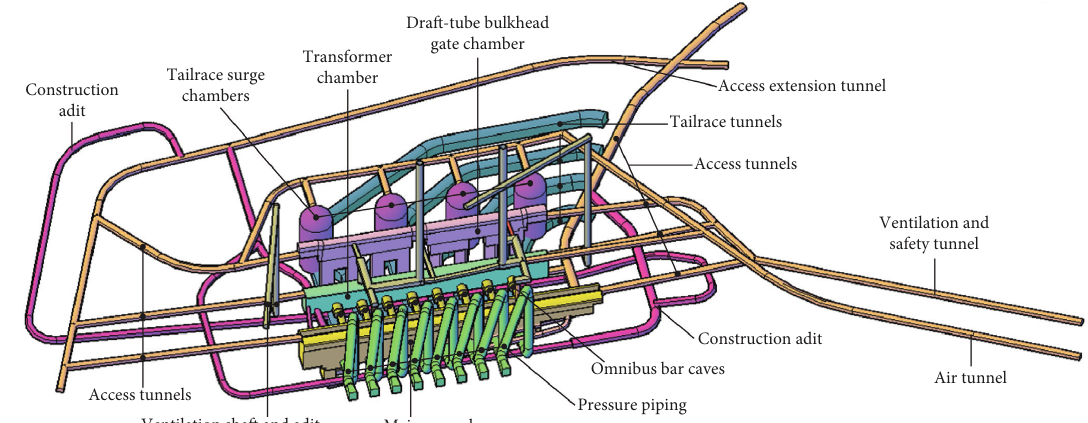
Figure 7: A three-dimensional representation of the Baihetan underground powerhouse.